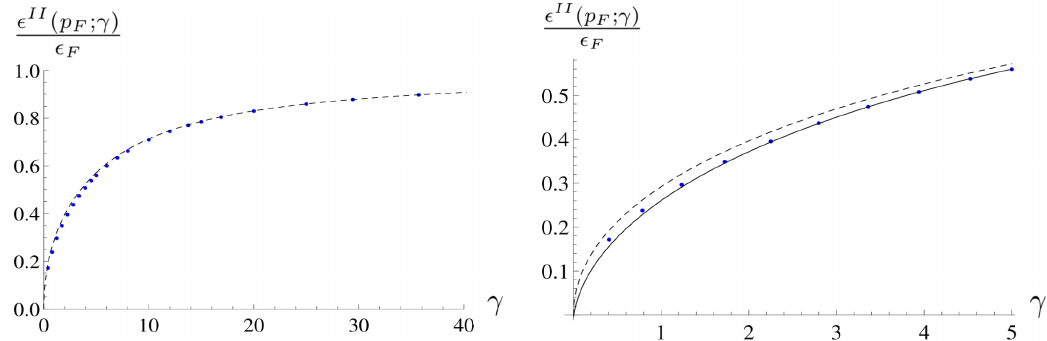
Figure 12: Maximum of the type II spectrum, ε II ( p ; γ ) , in units of the Fermi energy ε , as F F a function of the dimensionless interaction strength γ . The left panel shows the first order = 0 (dashed), compared to exact numerics (blue dots). approximation in Eq. (51) taking f 2 The right panel shows a zoom close to the origin and the second order approximation (solid, black). The agreement is significantly improved when using this